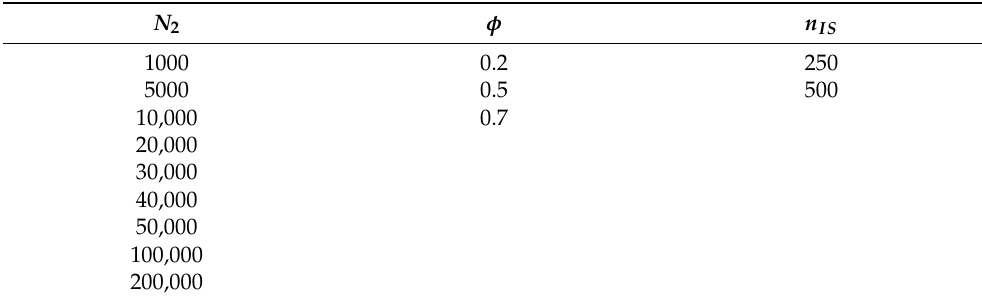
Table 1. Values of N 2 , φ , and n IS used in the simulation study.